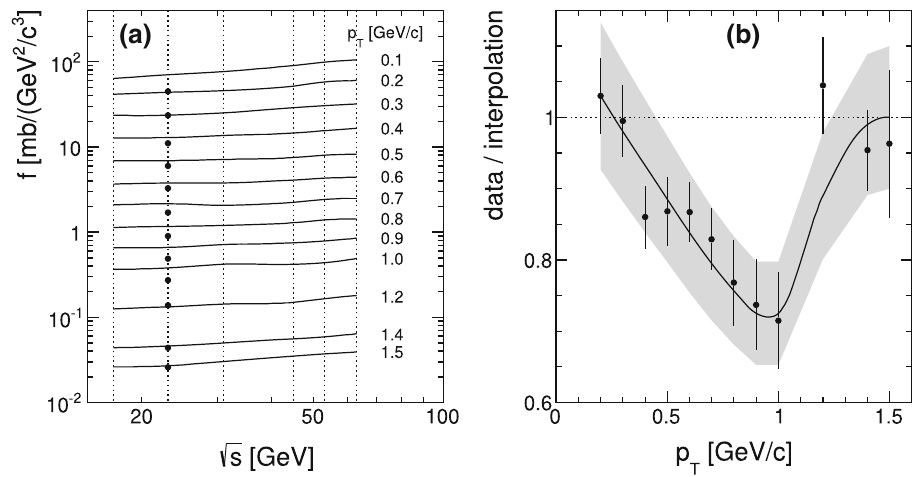
√ s = 23 GeV; b ratio between